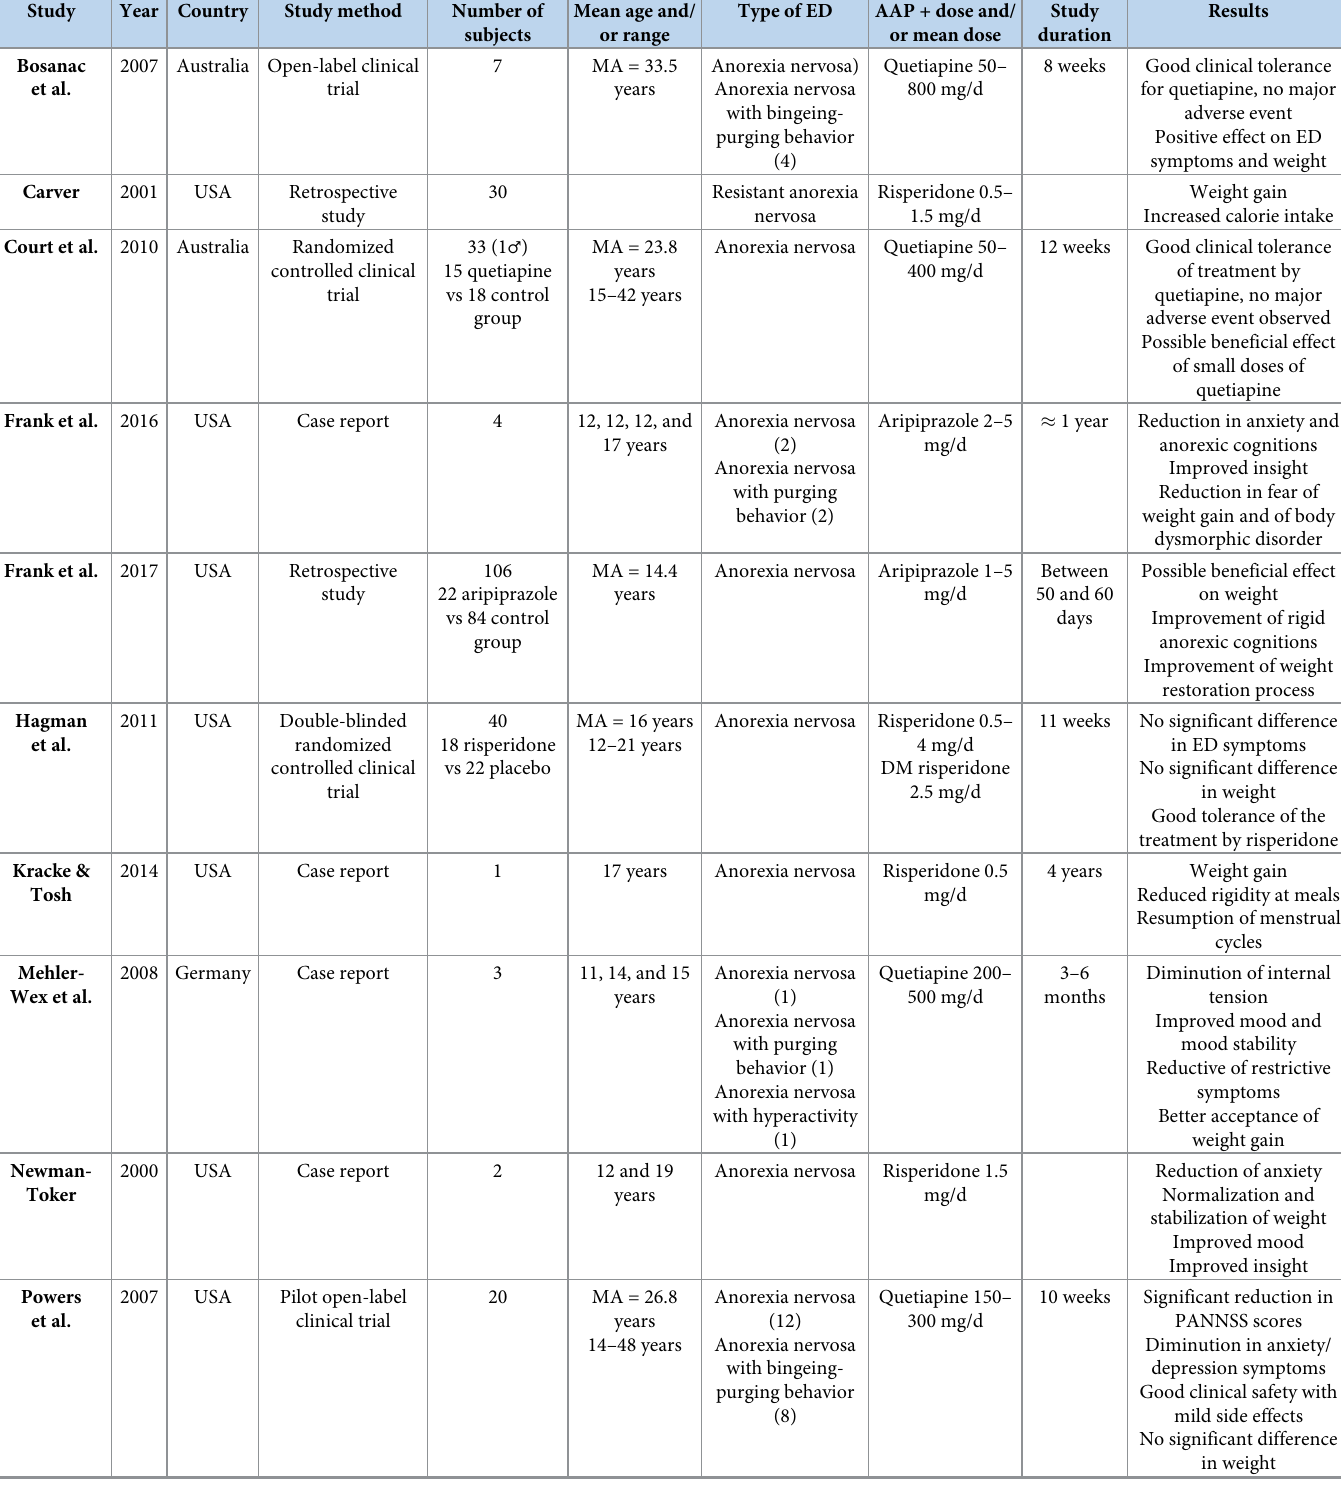
Table 2. Articles included in the scoping review concerning aripiprazole, quetiapine, and risperidone.